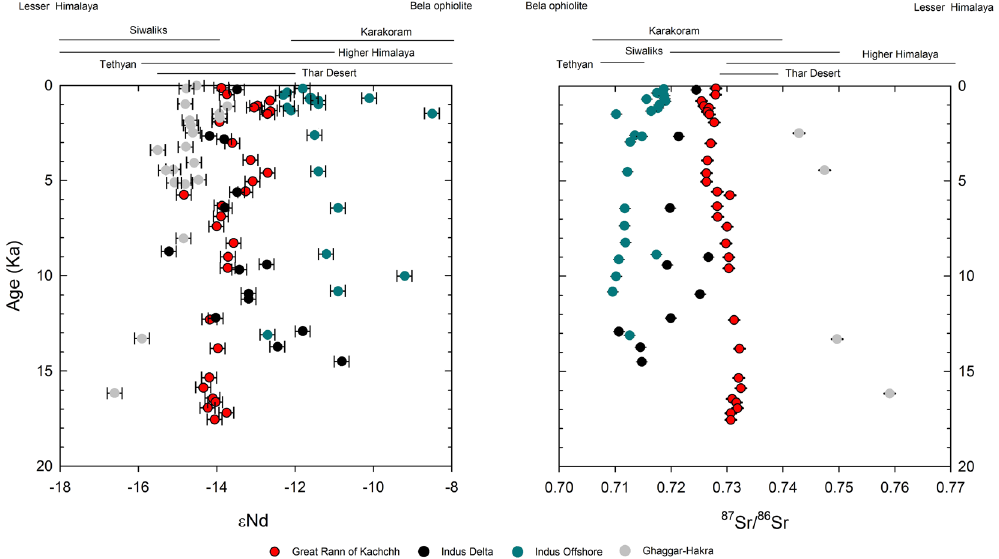
Figure 3. Deglacial and Holocene downcore variations in ε Nd and 87 Sr/ 86 Sr ratio values for GRK sediments plotted along with Indus River, Indus Shelf and Ghaggar-Hakra system. Ranges of variability for potential sources are shown at the top of each graph. Graphs were prepared using a licensed copy of Sigma Plot